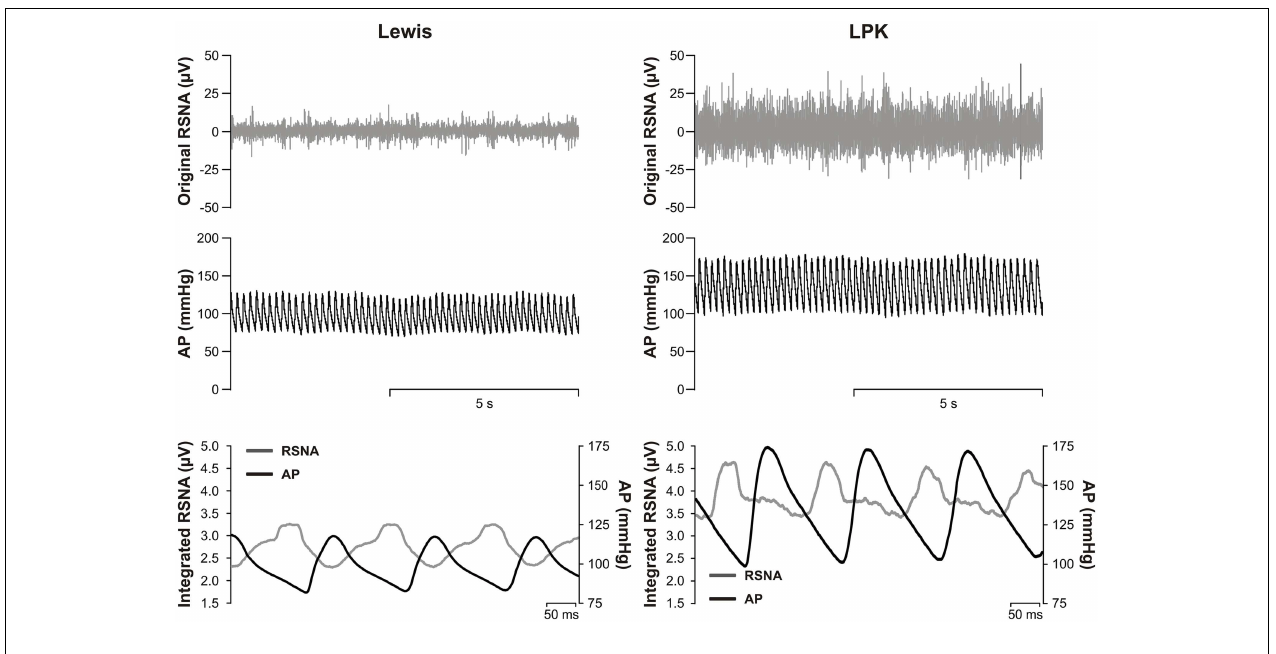
FIGURE 1 | Top, representative raw data traces of original renal sympathetic nerve activity (RSNA) and arterial pressure (AP) from conscious Lewis (left) and Lewis Polycystic Kidney (LPK, right) rats. Bottom, pulse modulation of RSNA using pulse triggered averages